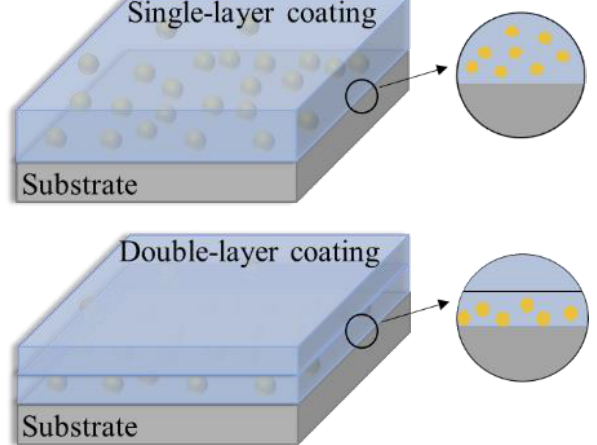
Figure 1. The diagram of two kinds of coating samples prepared.